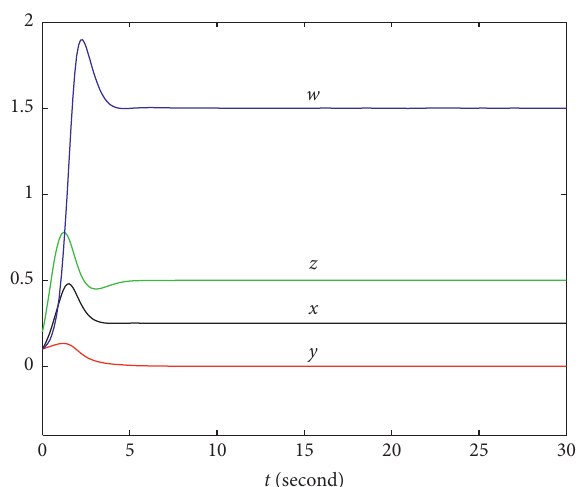
Figure 5: The values a � 2, b � 0.5, c � 3, d � 1, e � 2, f � 2, and g � 2 are used. So, we get the stable solution ( x � 0.25, y � 0, z � 0.5, and w �